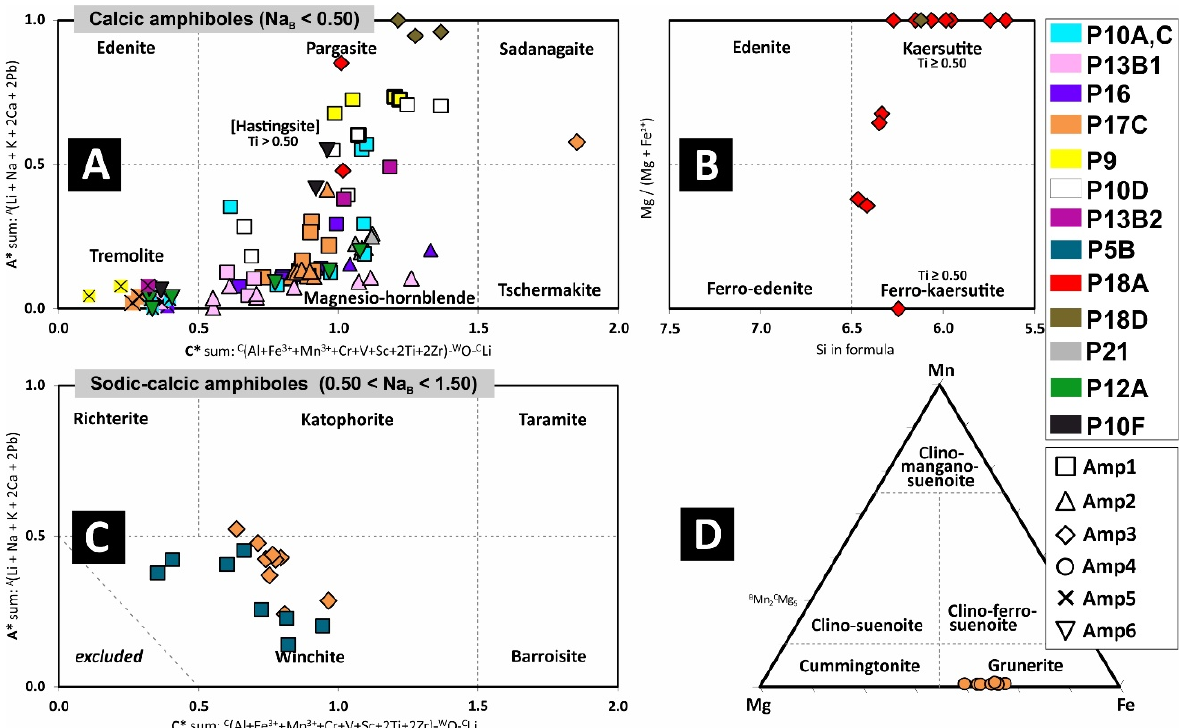
Figure 23. ( A – D ) Amphibole chemistry in ultramafic and mafic rocks. Classification from [56]. Amp1 with thick frame in ( A ) is Hst.